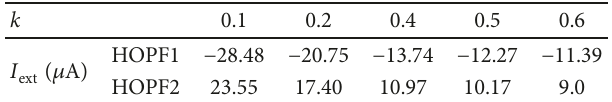
Figure 3: The regional distribution diagram of resting state and oscillating state under di ff erent initial values, for (a1 – e1) φ I ext = 40 , 50, 60, 70, and 80; for (a2 – e2) V 0 = 80 and I ext = 40 , 50, 60, 70, and 80; and for (a3 – e3) ω 0 = − 1 5 and I ext = 40 , 50, 60, 70, and 80. Table 1: Summary of the type and position of bifurcation point.